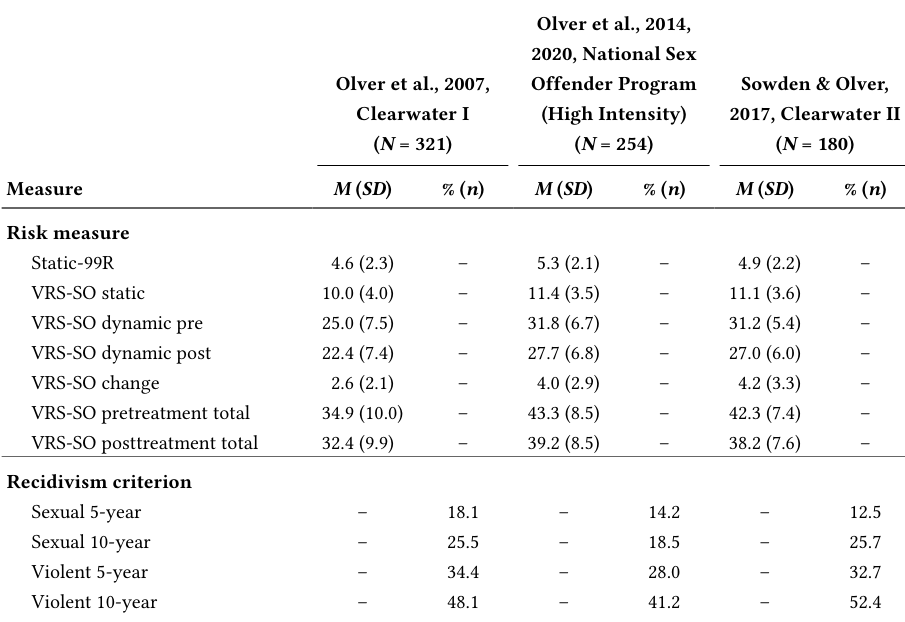
Note. VRS-SO = Violence Risk Scale-Sexual Offense